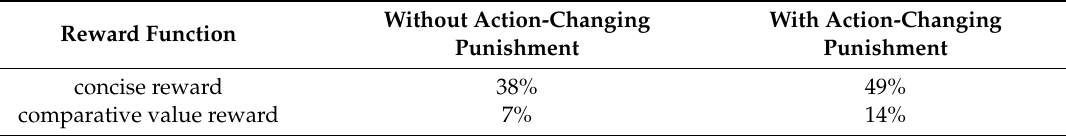
Table 7. Effect of adding action-changing punishment.